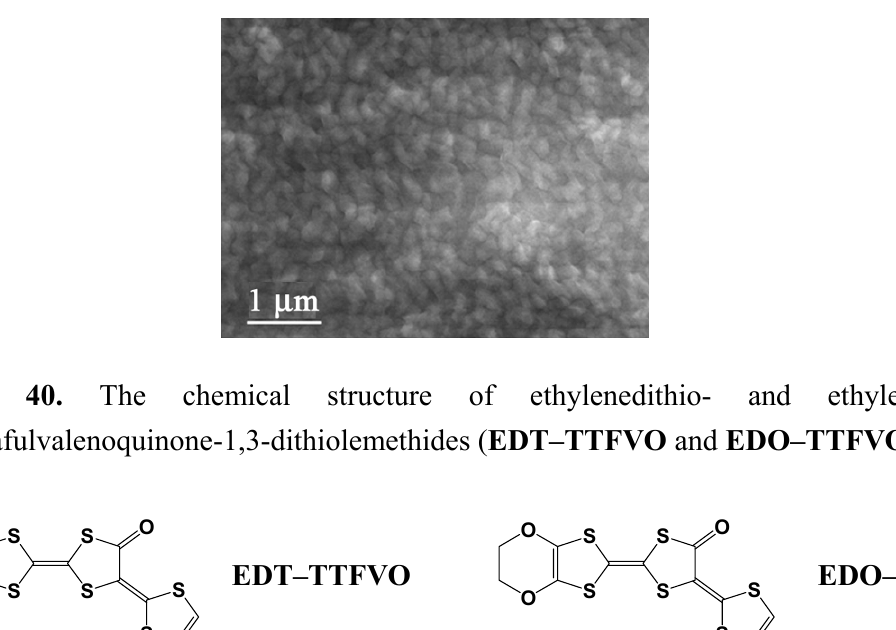
PC multilayers coated on a (001)–oriented silicon wafer. Figure 39. SEM image of DC 8,9 [Reproduced with permission from [16] New J. Chem. 2007 , 31 , 519–527. ©2007, the Royal Society of Chemistry and the Centre National de la Recherche Scientifique].